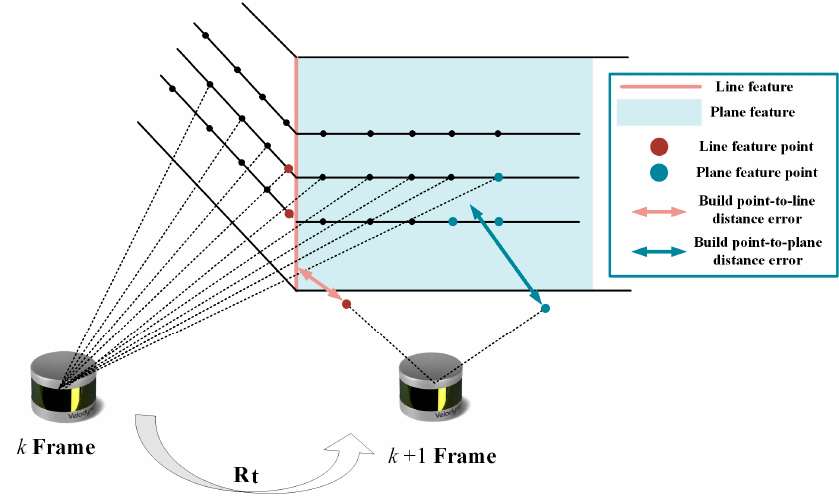
Figure 4. Inter-frame pose estimation in LOAM systems.